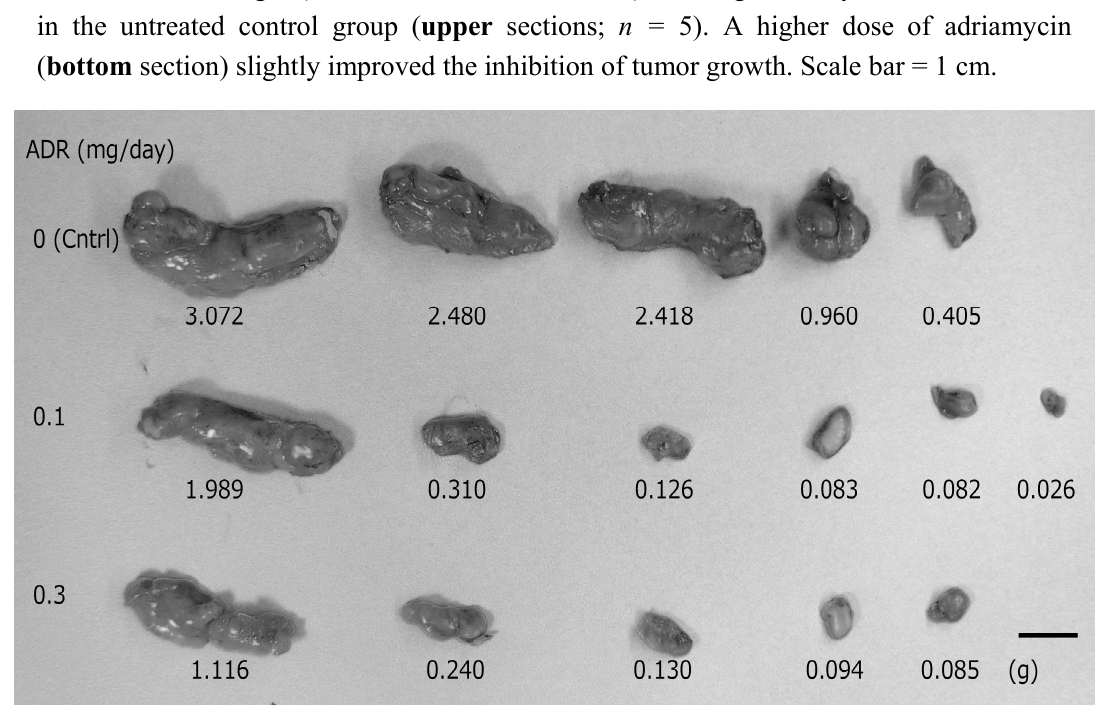
Figure 1. Effect of topically administered adriamycin on tumor growth in hairless